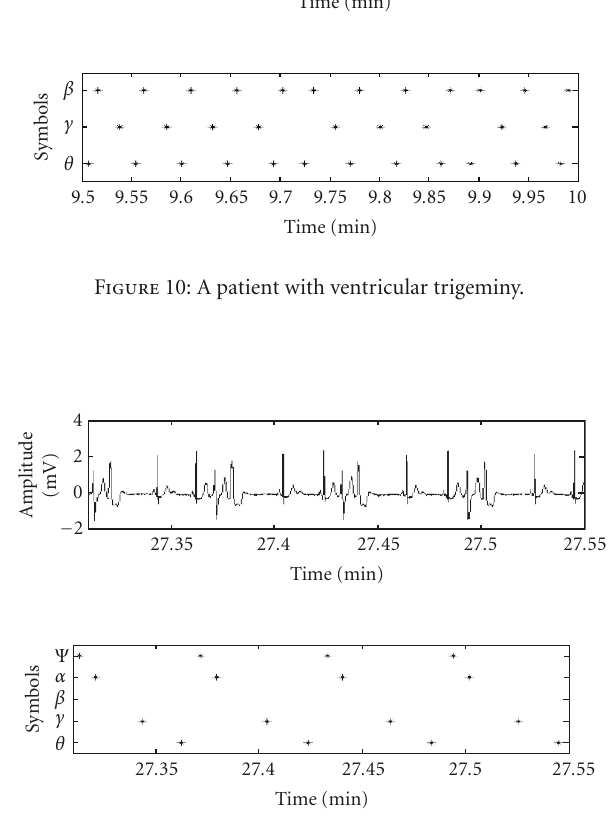
Figure 11: A rhythm of 4 units corresponding to an ectopic atrial rhythm.